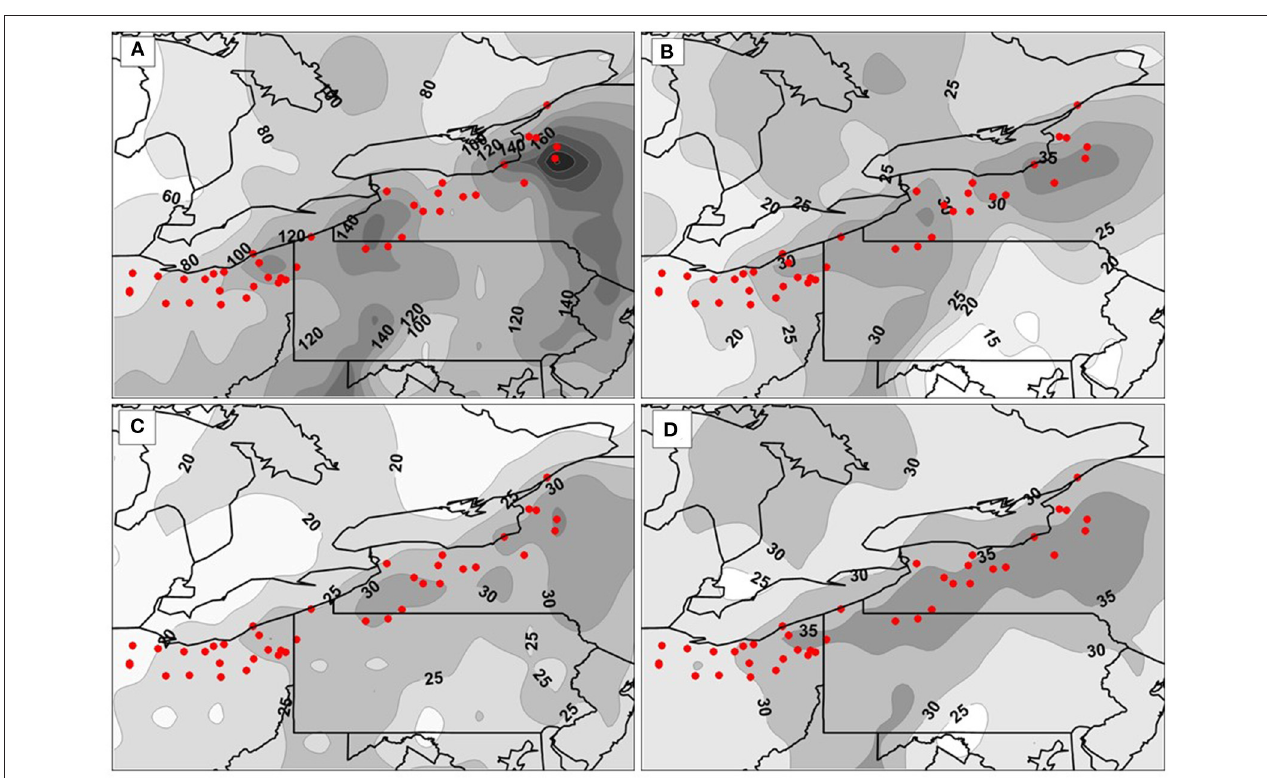
FIGURE 7 | Station-level values of mean seasonal precipitation (liquid; mm; 20mm intervals) (A) , precipitation frequency (days; 5-day intervals) (B) , percentage of seasonal precipitation (liquid; 5% interval) (C) , and percentage of seasonal precipitation frequency (5% interval) (D) associated with the lake-effect days of the hybrid data set, 1964–65 through 2014–15. Red dots indicate locations of stations used to calculate regional